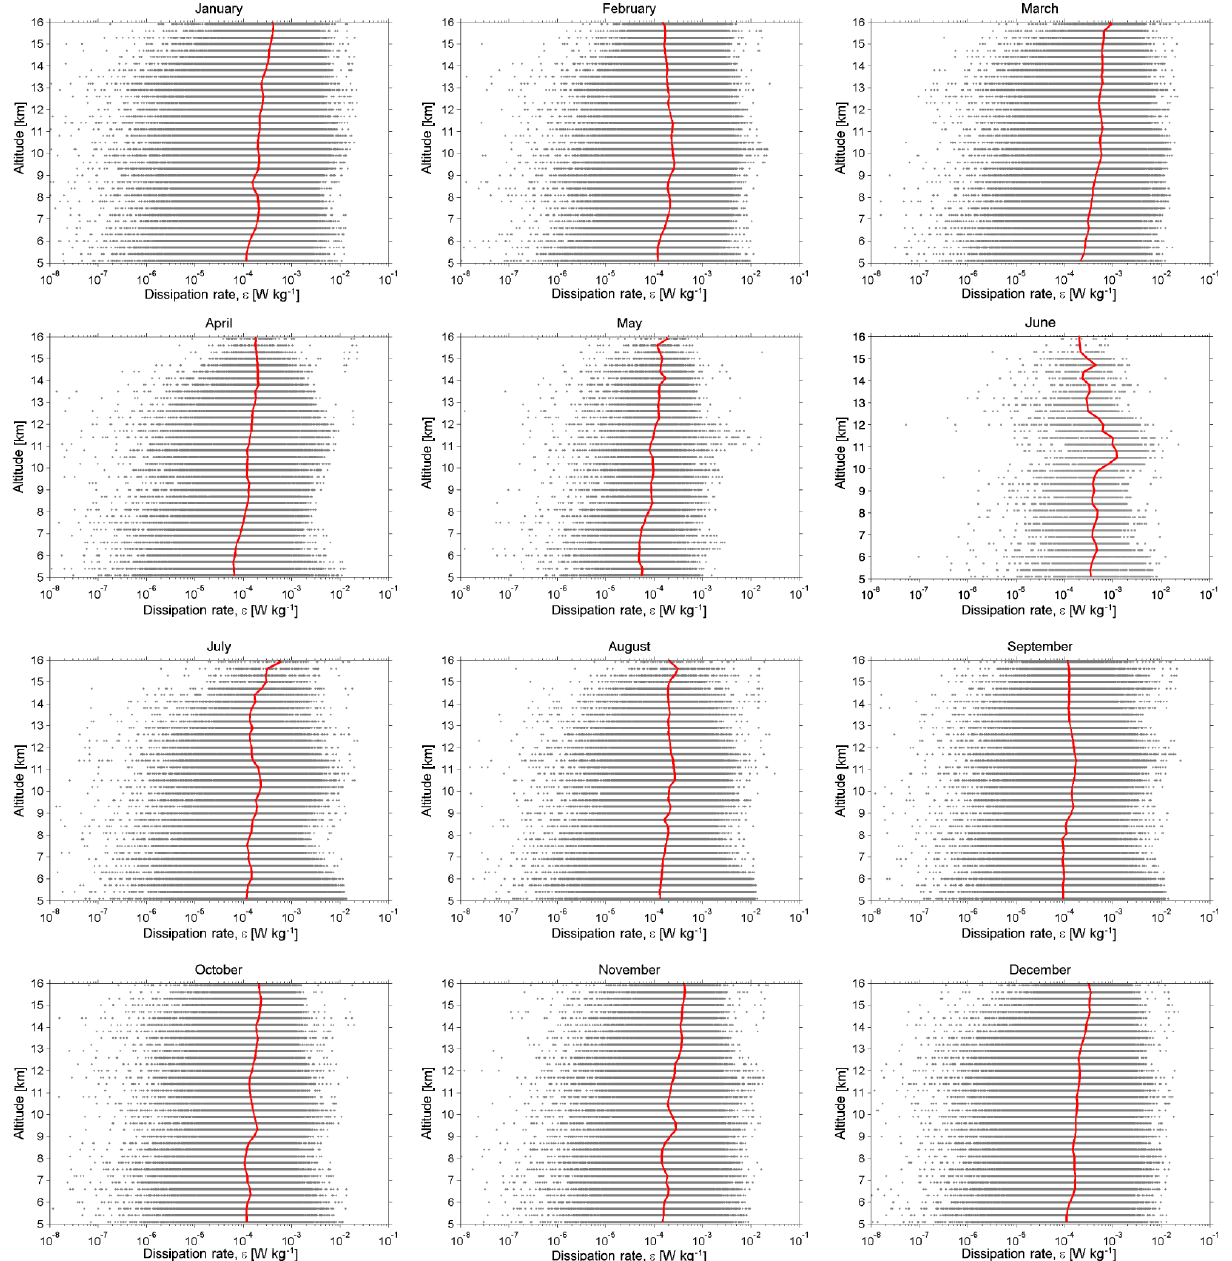
Figure 9. Scatter plots of turbulent energy dissipation rate derived from the radar observations with MAARSY in the years of 2011–2013 for different months and the corresponding median values shown in red (solid